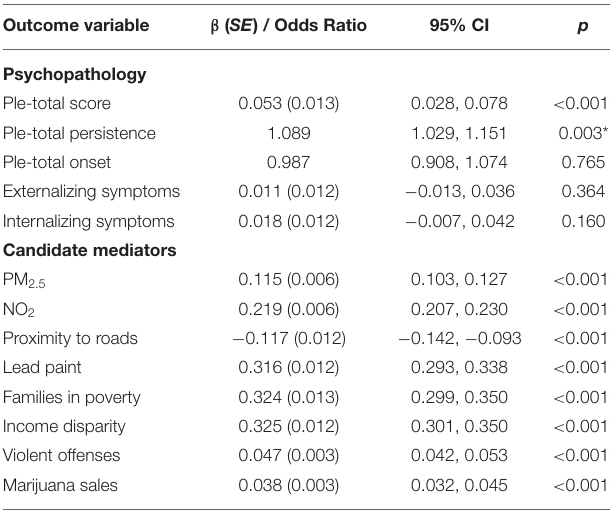
TABLE 2 | Associations between urbanicity (predictor), psychopathology, and candidate